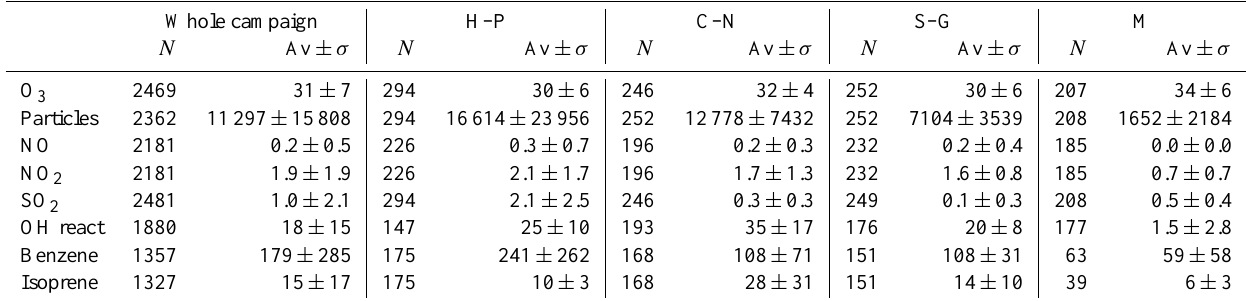
Table 4. Data number ( N ), average and standard deviation (Av ± σ ) in ppb (O 3 , NO, NO 2 , SO 2 ) , ppt (isoprene and benzene), particlescm − 1 (particles) and s − 1 (OH reactivity) for the whole campaign and for data classified into distinct sectors of air mass origin: Huelva–Portugal (H–P), continental–north (C–N), Seville–Guadalquivir (S–G) and marine (M).